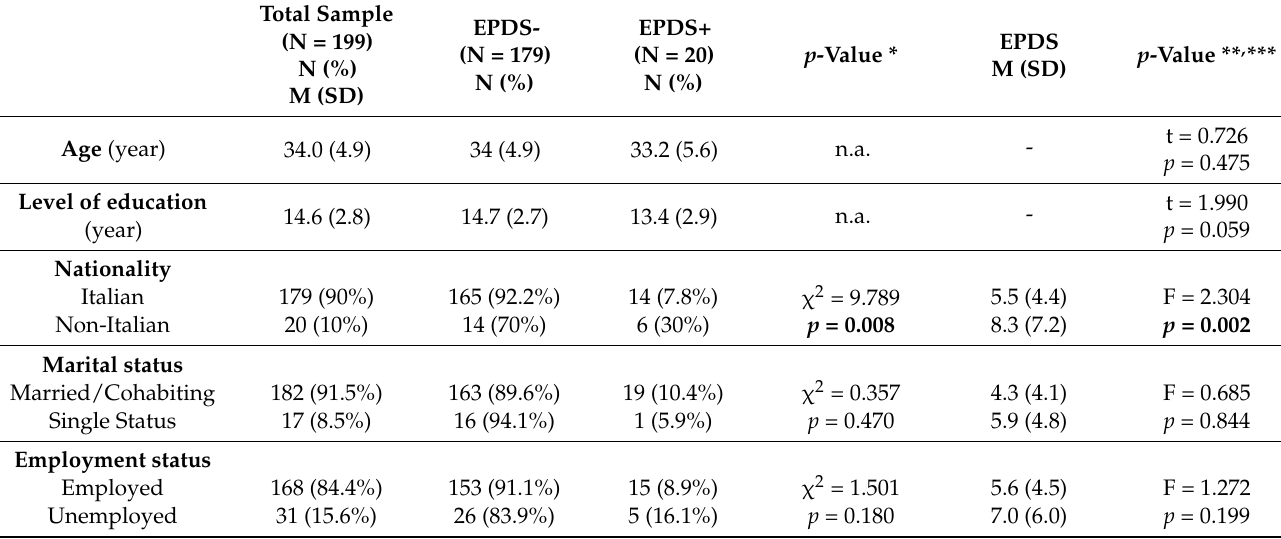
Table 1. Socio-demographic characteristic of the sample.